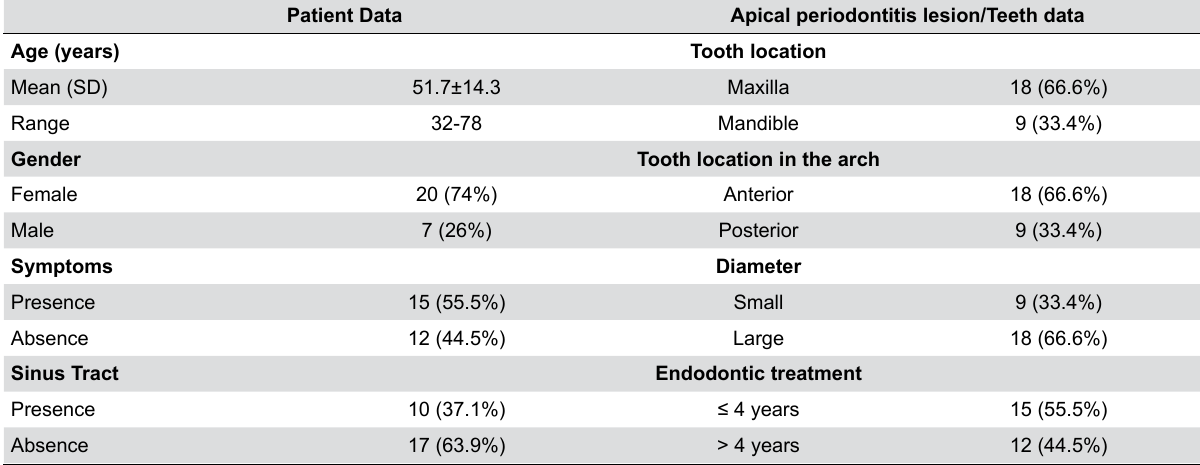
Table 1- Demographic, clinical, and cone-beam computed tomographic